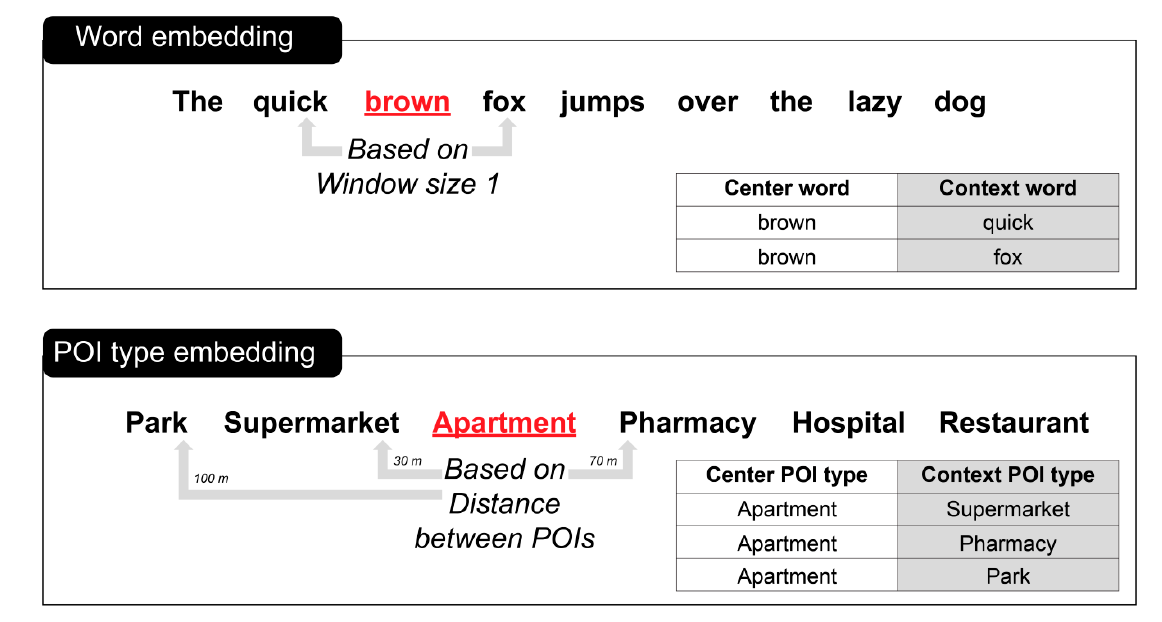
Figure 2. Word embedding vs. POI type embedding.